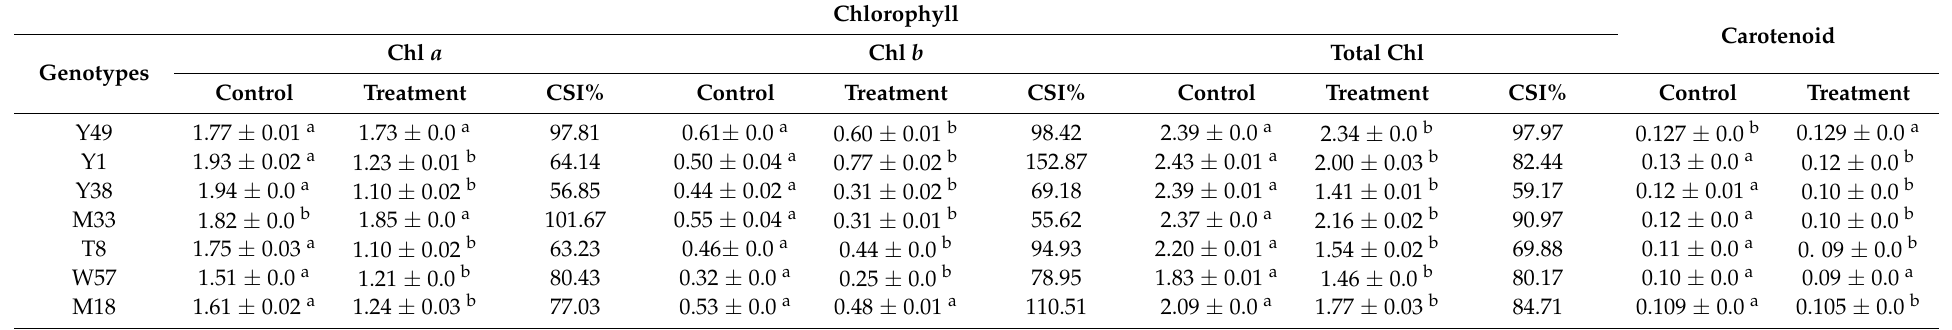
Table 2. Changes of chlorophyll content compared to control, chlorophyll stability index (CSI), and carotenoid in different varieties under exposure to cold